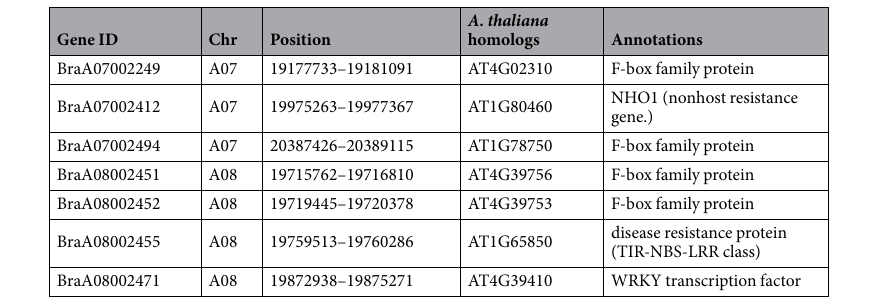
Table 4. Candidate gene